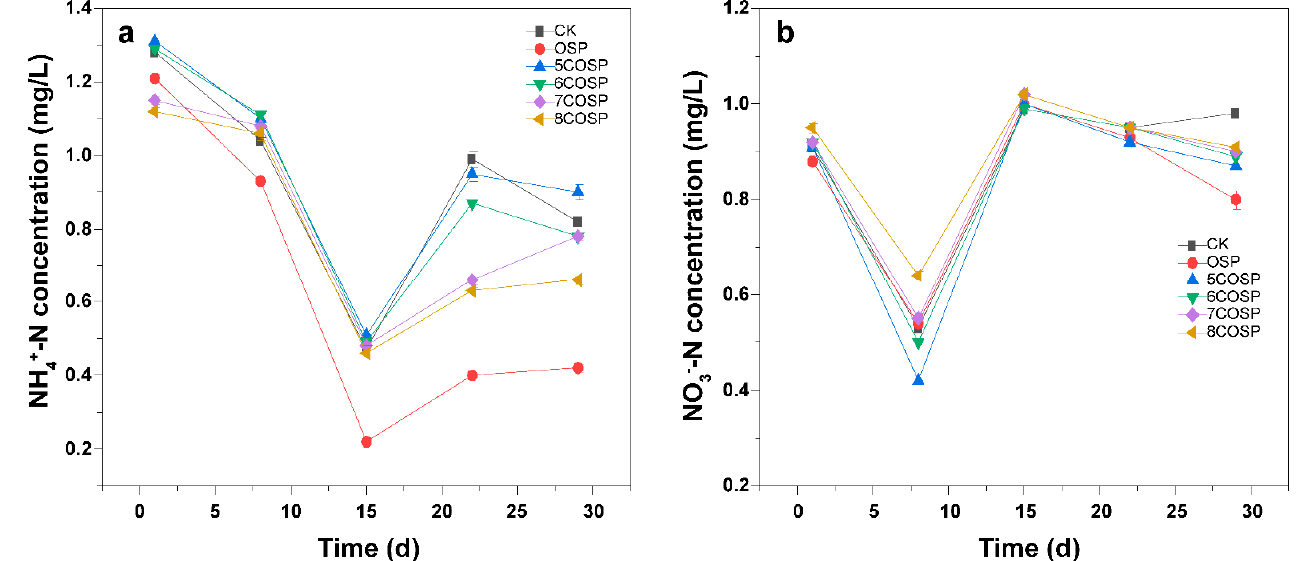
Figure 9. Variations in ( a ) NH 4+ -N and ( b ) NO 3 − -N concentrations of the leachate from the soil column under various treatments. CK: Urea treatment with N application level of 200 mg/kg; OSP: 0.2 wt.% OSP; 5–8COSP: 0.2 wt.% OSP calcined at various temperatures; particle size of the OSP and four COSPs = 0.15 mm.